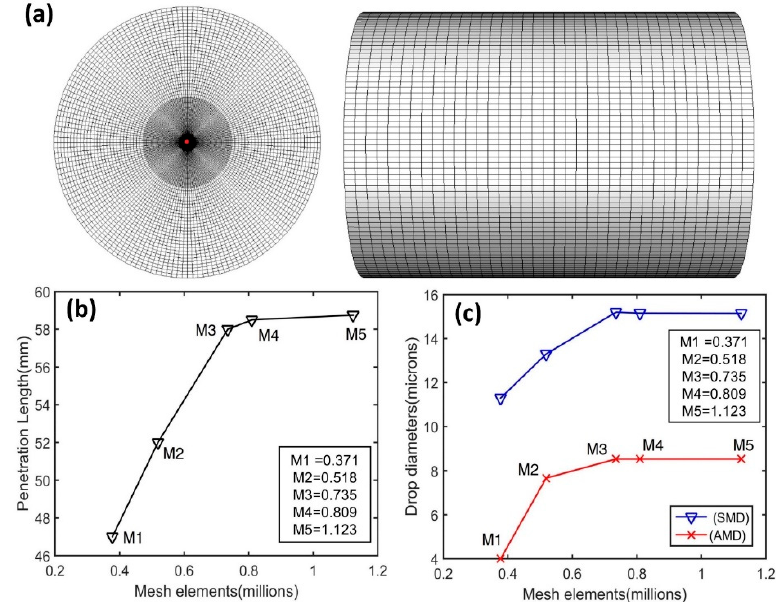
Figure 4. ( a ) Computational domain showing front and side views. ( b ) Penetration length at different mesh sizes. ( c ) Droplet diameters at different mesh sizes.